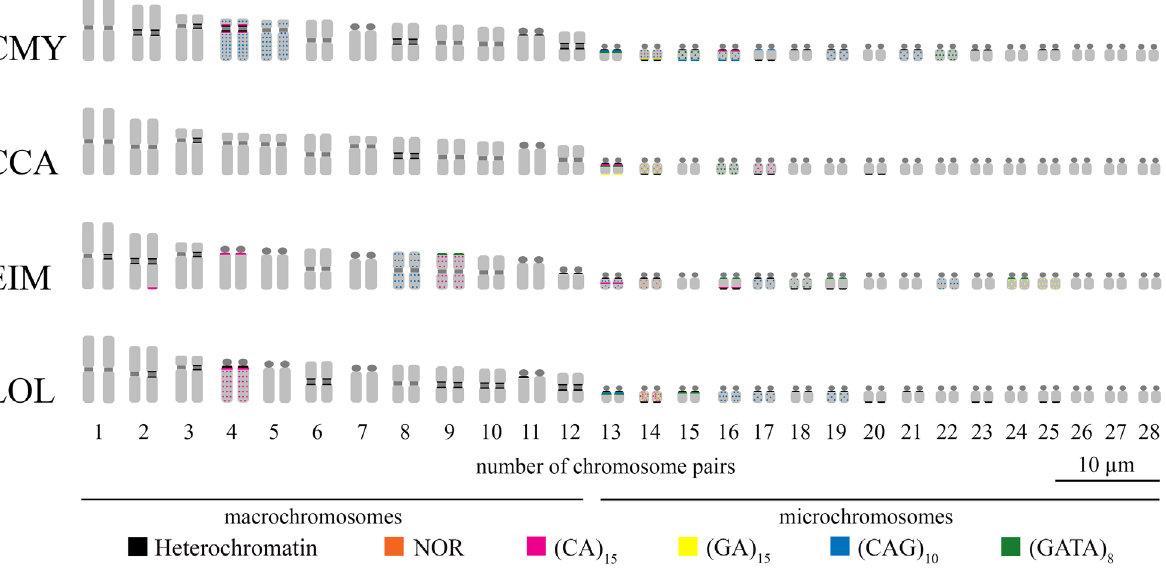
Figure 2 – Representative idiograms of heterochromatic regions, NOR and microsatellite motifs on the chromosomes of the four sea turtle species. The species names were referred by their 3-letter acronym: C. mydas (CMY), C. caretta (CCA), E. imbricata (EIM) and L. olivacea